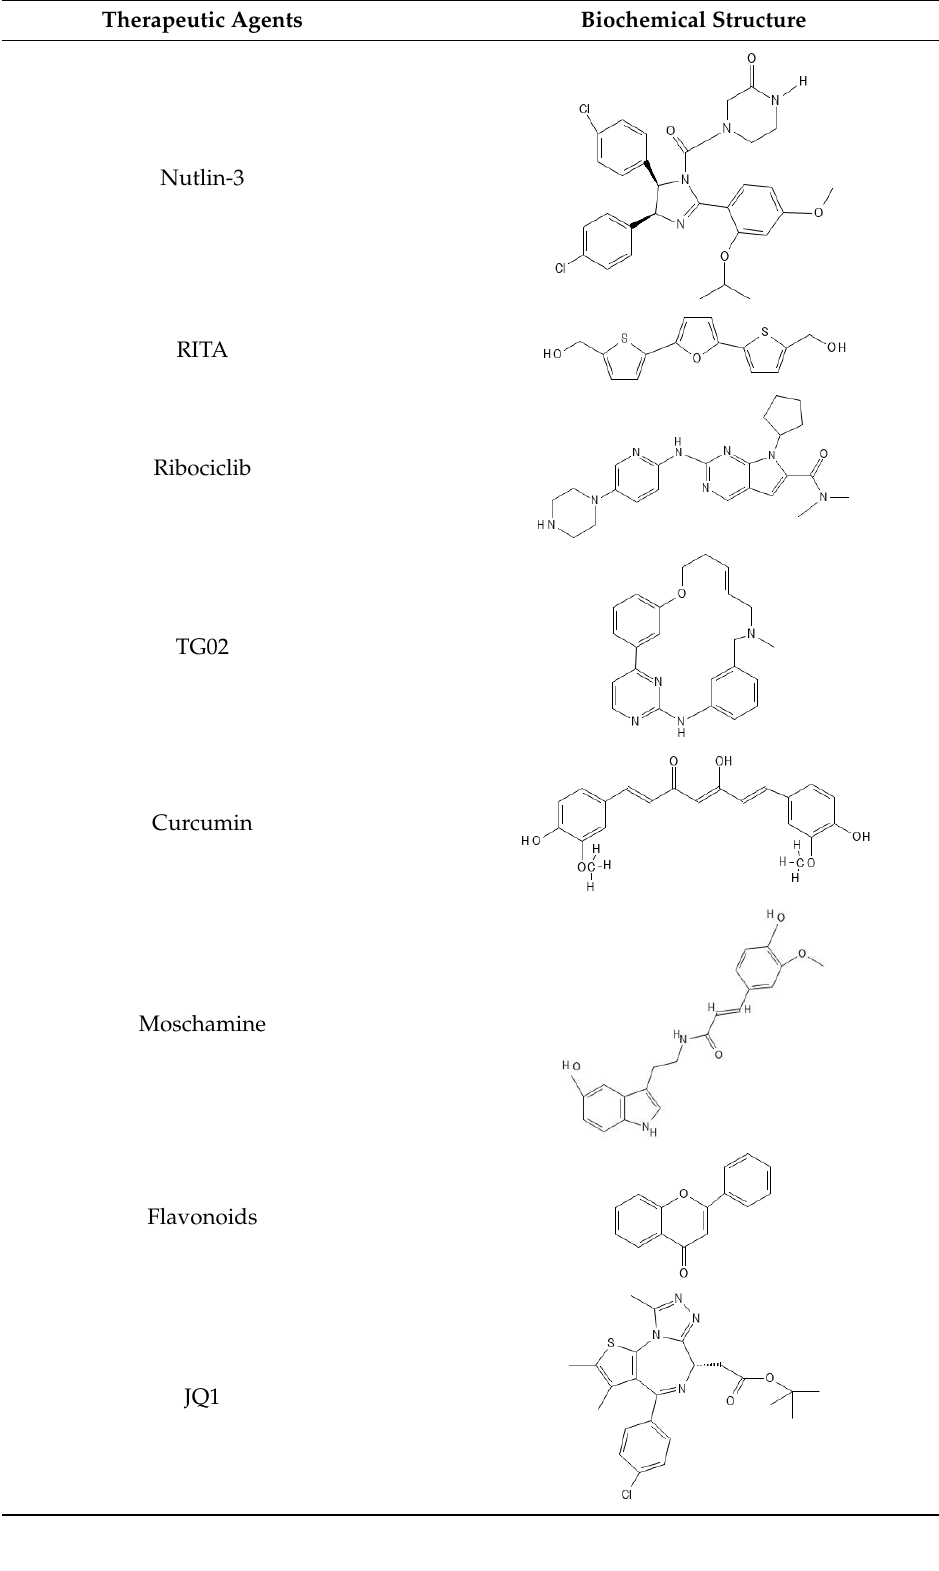
Table 2. Biochemical structures of potential therapeutic agents in GBM.